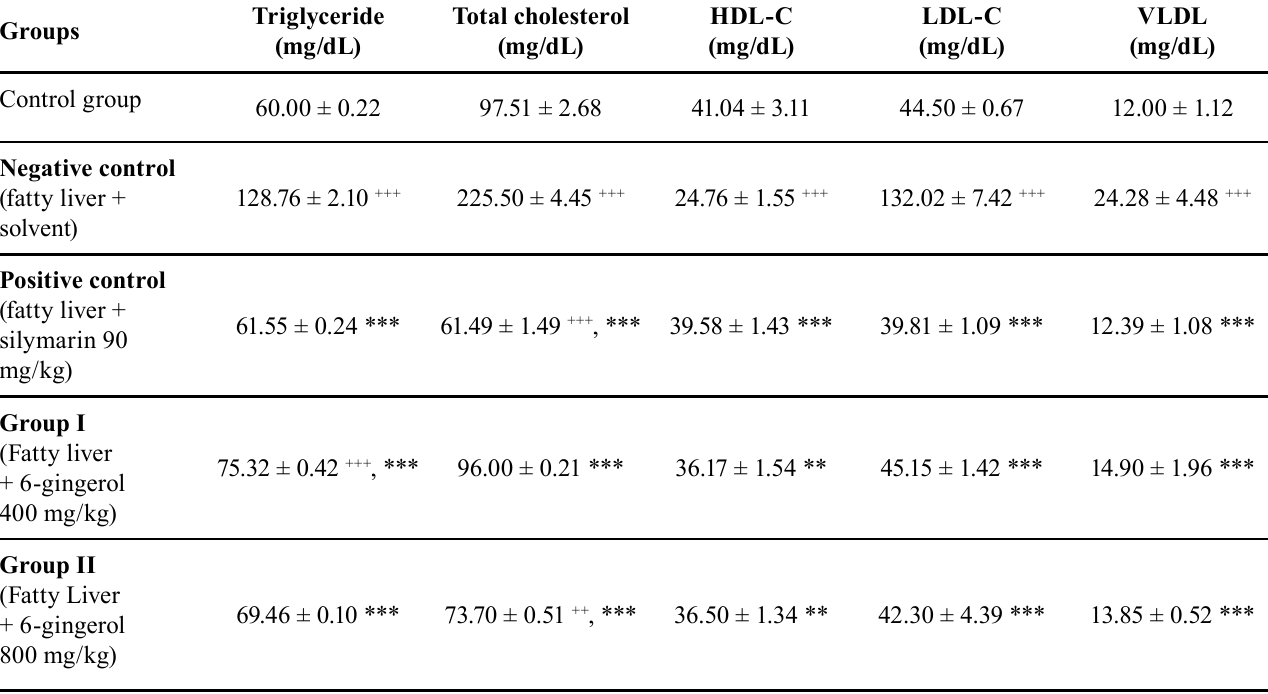
TABLE II – Changes in liver lipid profile in mice receiving control diet, high-fat diet, and 6-gingerol. n =